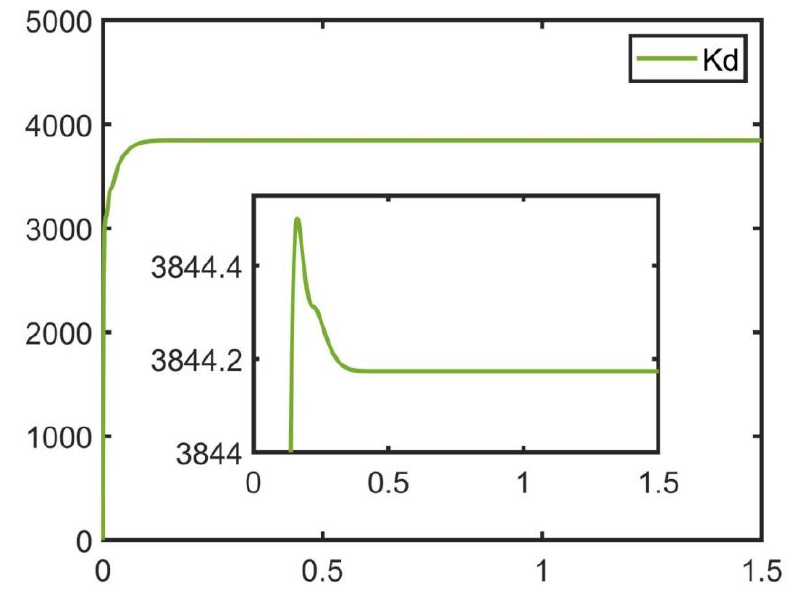
Figure 6. Adaptive adjustment curve of k d .